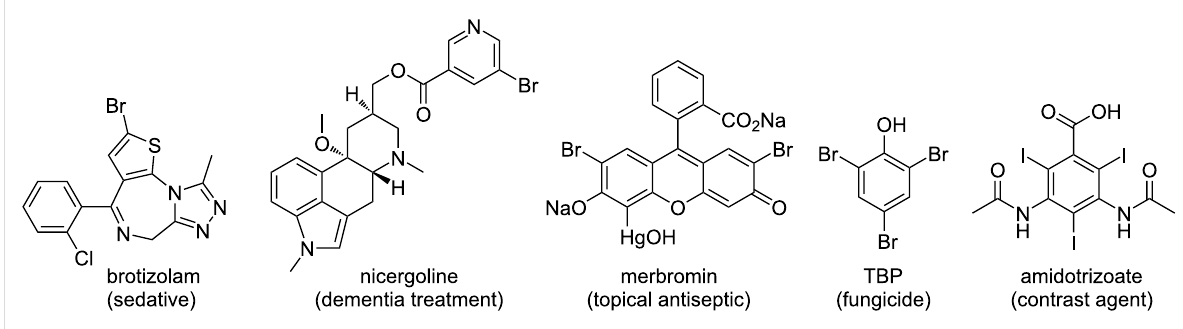
(<50%), formation of corrosive byproducts (e.g., HBr) [15,16], which cause serious environmental issues. To mitigate the prob- lem, several mild and operationally safe halogenating agents have been successfully introduced to replace X 2